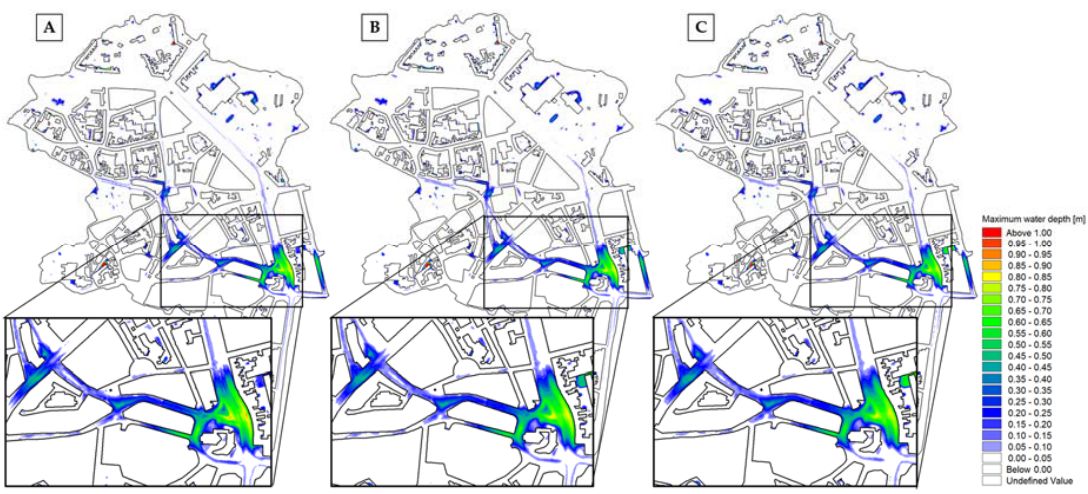
Figure 7. Maximum inundations maps on the basis of HP-model setting using maximum mesh sizes of 1 m 2 ( A ), 5 m 2 ( B ) and 8 m 2 ( C ).